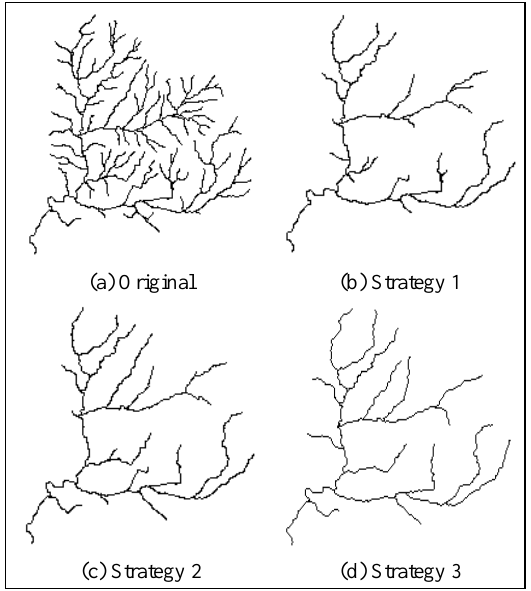
Figure 6 Generalised river network for dendritic